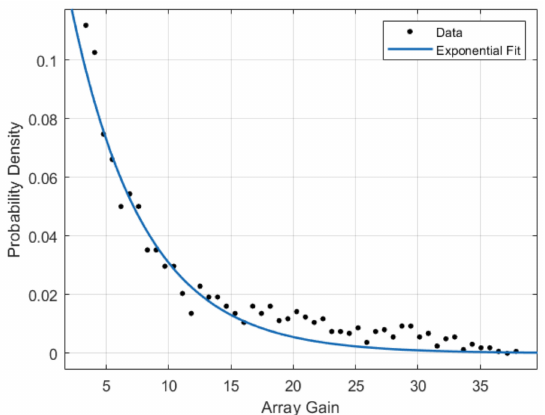
Figure 3. Plot of the fit of the antenna array gain into an exponential distribution for a rectangular uniform antenna array with N tx = 256 antenna elements.